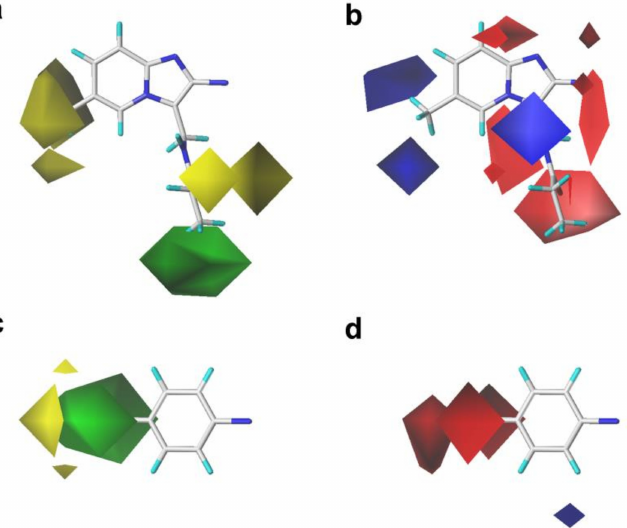
Figure 6. Contour maps of the Topomer CoMFA model with compound 14 as a template. ( a ) and ( c ) Steric fields for part R a and R b , respectively; ( b , d ) electrostatic fields for part R a and R b ,